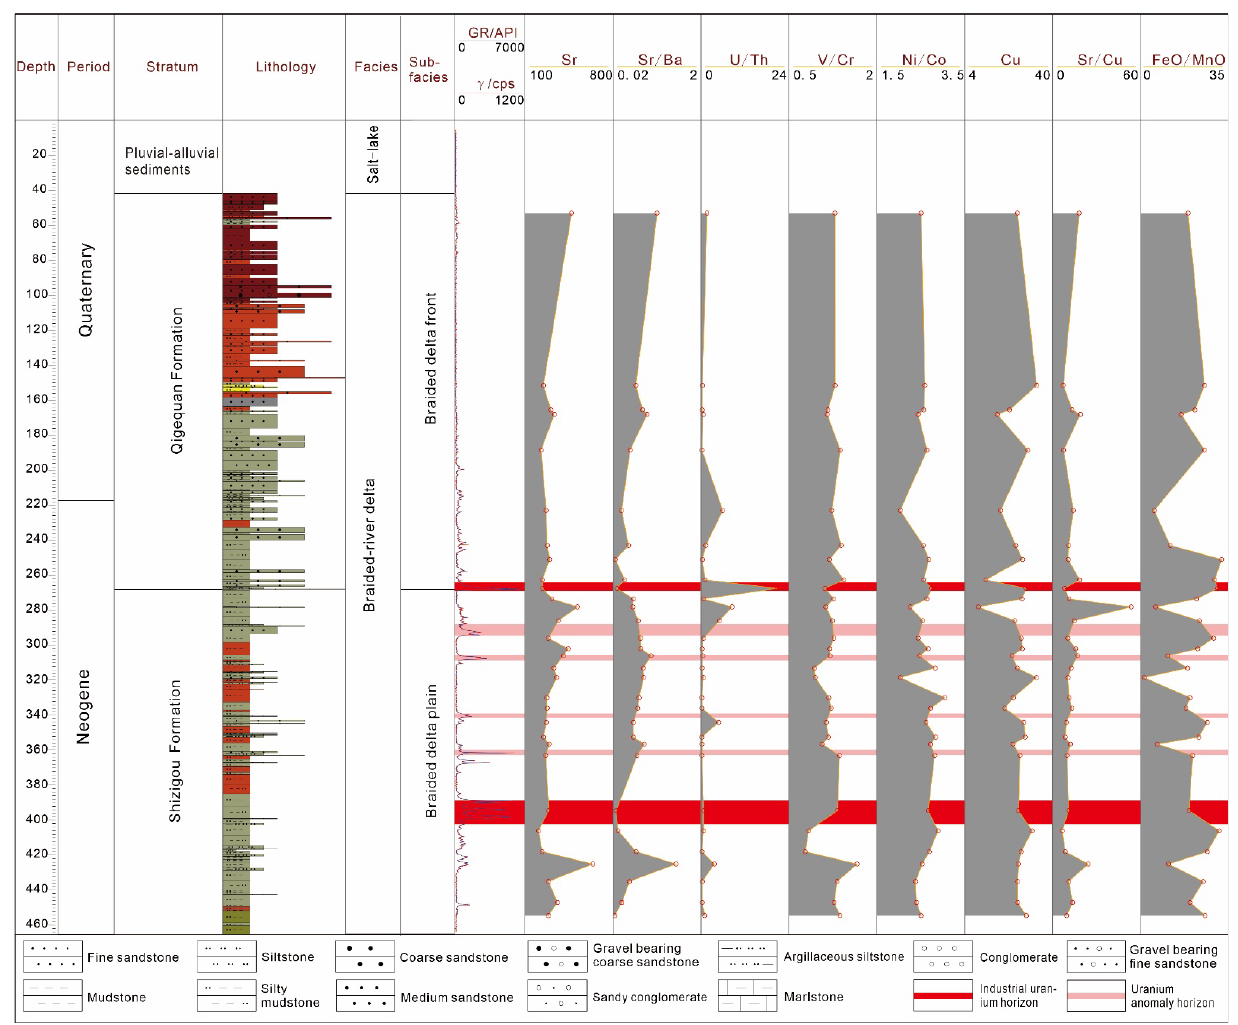
Figure 5. The comprehensive columns of ZKII-05 to illustrate the strata, lithologies, facies, sub-facies and variation trend of representative elements and elemental ratios. The filled color of the lithology column represents its respective catalog color.